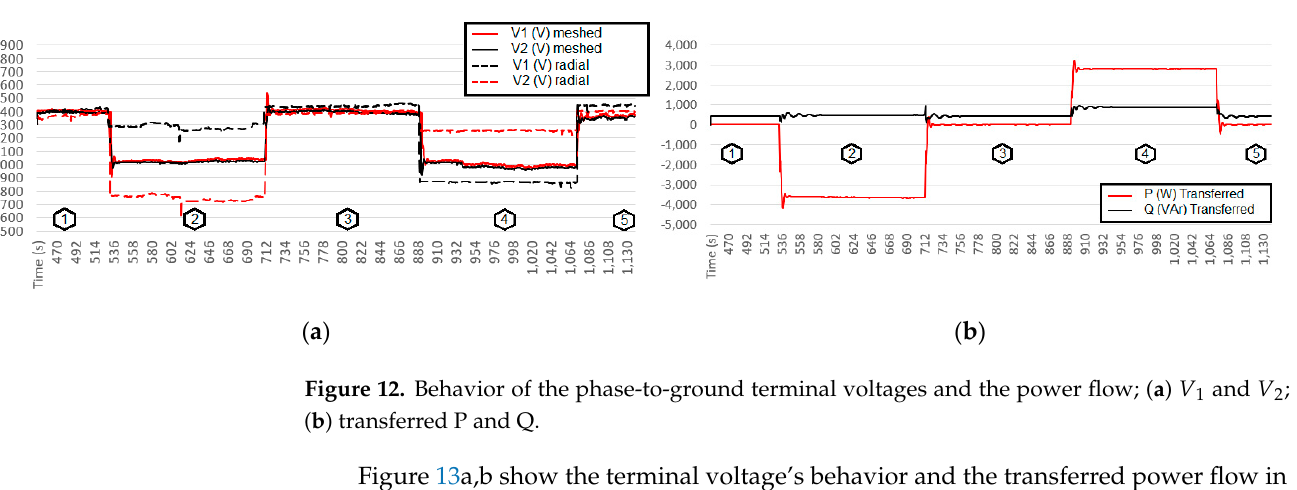
14 of 23 Table 2 . Transformer setup. Transformer Data